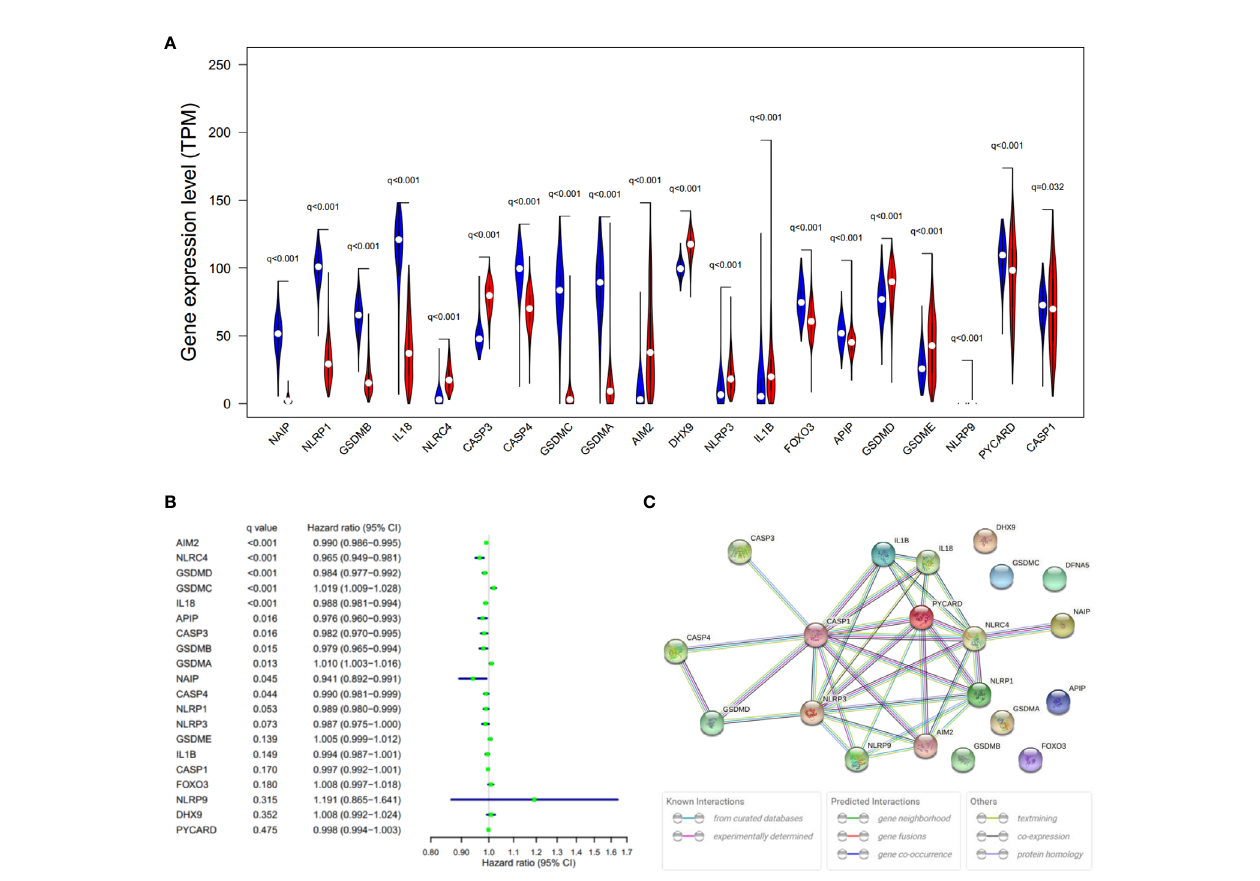
FIGURE 2 | Expressions and the associations with OS of the 20 PRGs. (A) Violin plot of PRGs between the normal (blue) and the tumor tissues (red). q, FDR-adjusted p-value. (B) Signi fi cance and hazard ratio (95% CI) values of OS-related PRGs in univariate Cox regression. CI, con fi dence interval. q, FDR-adjusted p-value. (C) PPI network showing the interactions of the PRGs (interaction score = 0.9). The bottom boxes show the types of